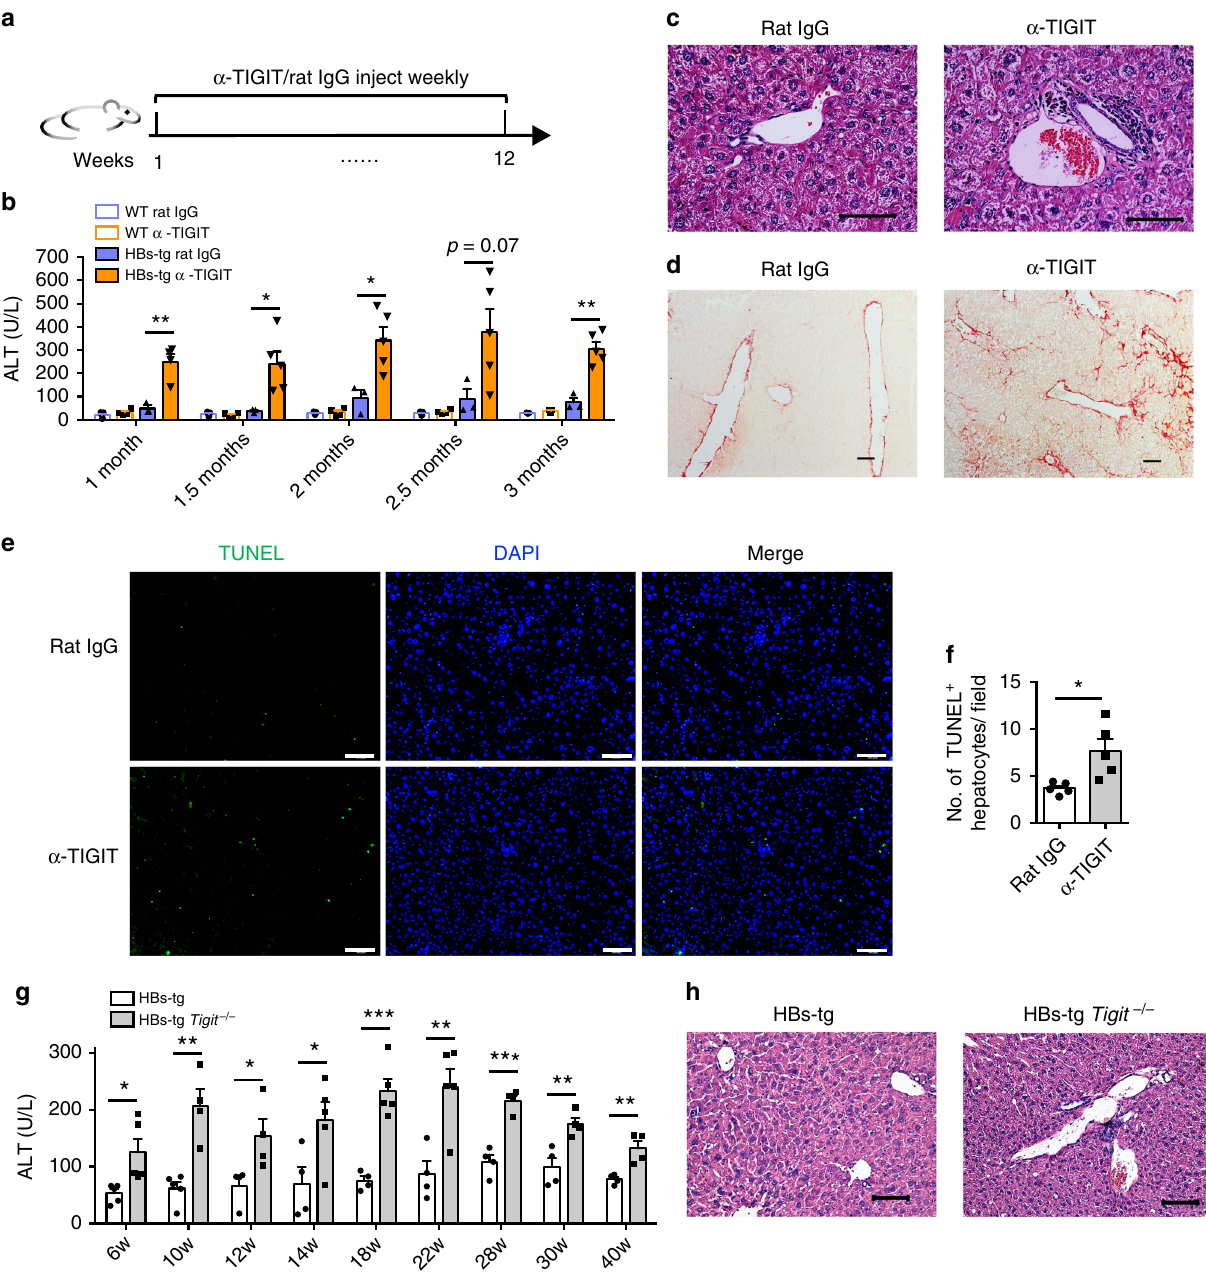
Fig. 1 TIGIT blockade or TIGIT de fi ciency induces chronic hepatitis in HBs-tg mice. a – e HBs-tg or WT C57BL/6 mice were intraperitoneally injected with 200 μ g α -TIGIT mAb or control rat IgG weekly. a Schematic of antibody treatment in mice. b Serum ALT levels at different time points after start of antibody treatment in HBs-tg or WT mice ( n = 3 – 5 in each group). c , d Representative H&E ( c ) or sirius red staining ( d ) of liver tissue sections in HBs-tg mice after a 3-month treatment with α -TIGIT antibodies or rat IgG. Scale bar, 50 μ m. e TUNEL labeling shows apoptotic pro fi les in liver tissue sections in HBs-tg mice after a 3-month treatment with α -TIGIT antibodies or rat IgG. Green-TUNEL, blue-DAPI (nuclei). Scale bar, 100 μ m. f The number of TUNEL- positive hepatocytes per fi eld was determined after a 3-month treatment with α -TIGIT antibodies or rat IgG. TUNEL-positive lymphocytes were excluded ( n = 5 in each group). g Serum ALT levels of HBs-tg and HBs-tg Tigit − / − mice at the indicated ages ( n = 4 – 5 in each group). h Representative H&E staining of liver tissue sections from HBs-tg and HBs-tg Tigit − / − mice. Scale bar, 100 μ m. Statistically signi fi cant differences between the groups are presented as the mean ± SEM.: * P < 0.05; ** P < 0.01; and *** P < 0.001 (two-tailed unpaired Student ’ s t -test). Data are representative of three independent